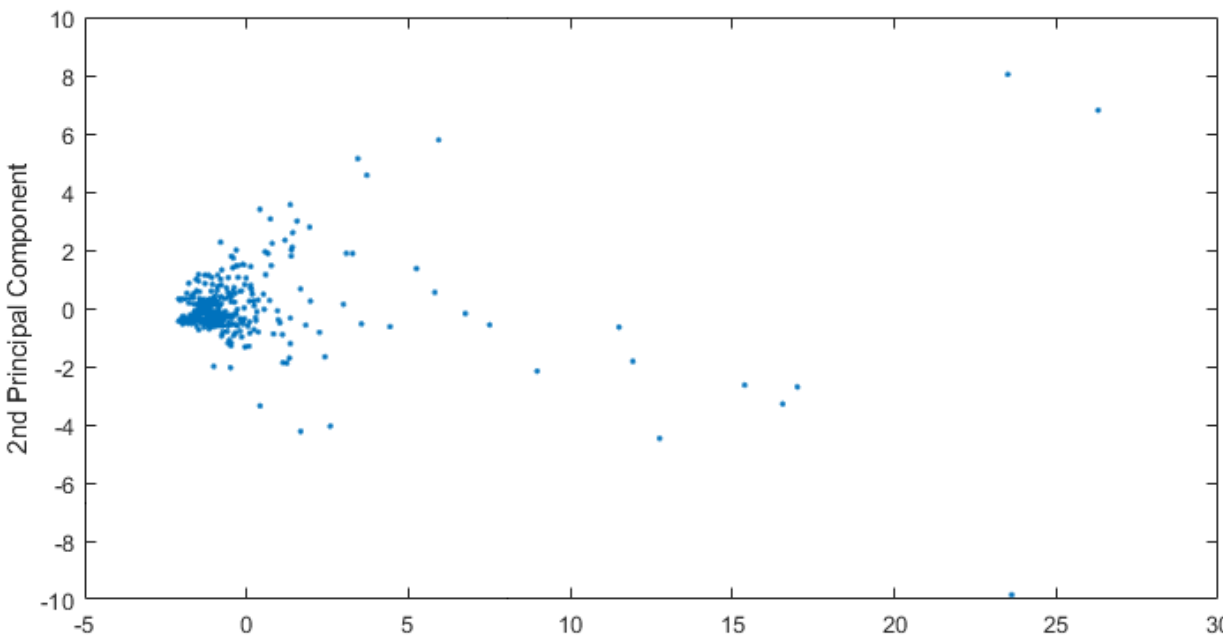
Figure 3. Observations scatter plot which depicts the observations after variable reduction.